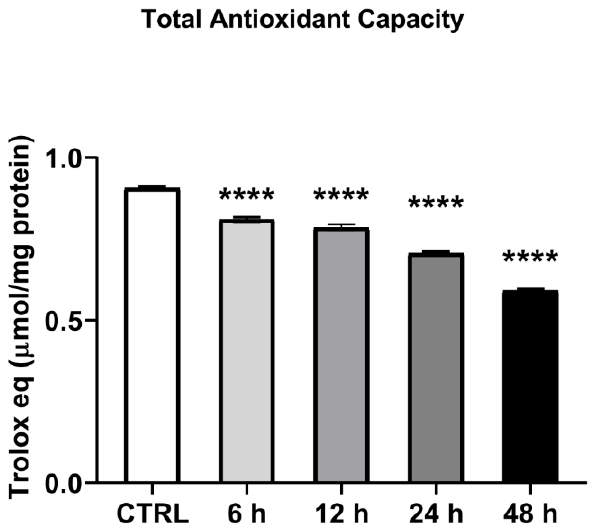
Figure 3. H 2 O 2 treatment and total antioxidant capacity. C2C12 myoblasts were treated with H 2 O 2 0.3 mM for different times (6–48 h) and cell lysates were tested for TAC analysis. TAC levels were expressed as micromoles of Trolox equivalents/mg of protein tested. Data presented are the mean ± SEM of three experiments, each performed in triplicate. One ‐ way ANOVA was performed followed by Bonferroni’s multiple comparisons test **** p < 0.0001 vs. CTRL.